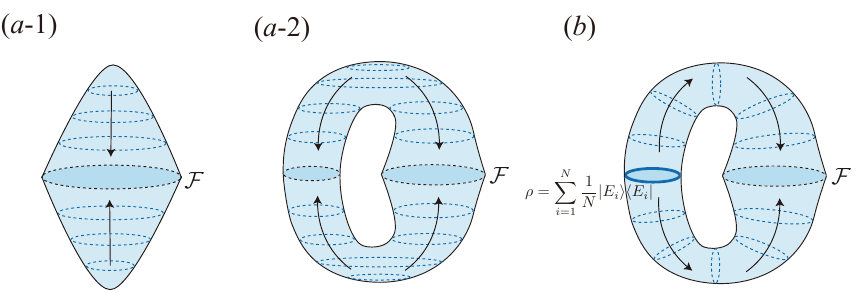
Figure 9 . ( a -1)( a -2): Hartle-Hawking no boundary initial condition fixes the initial timeslice to have zero volume. When L/φ b is sufficiently large, ( a -2) dominates over ( a -1), see [40]. ( b ): we can also view the bra-ket wormhole as taking thermal mixed state as the initial